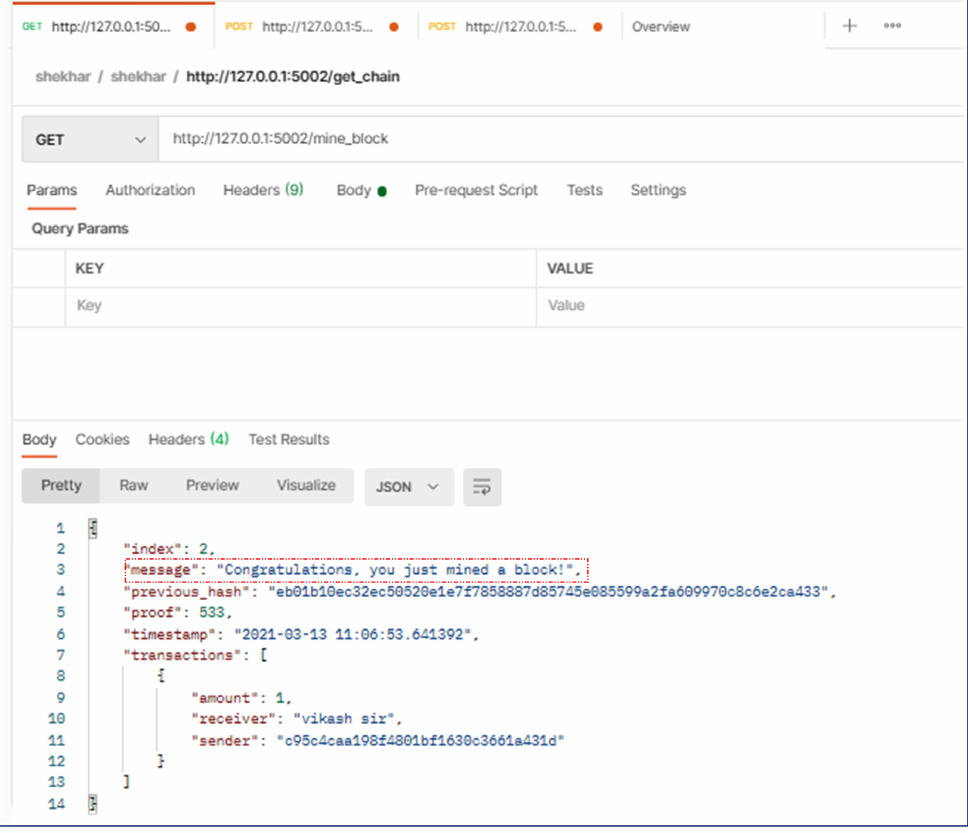
Figure A6. Mined a Block using GET